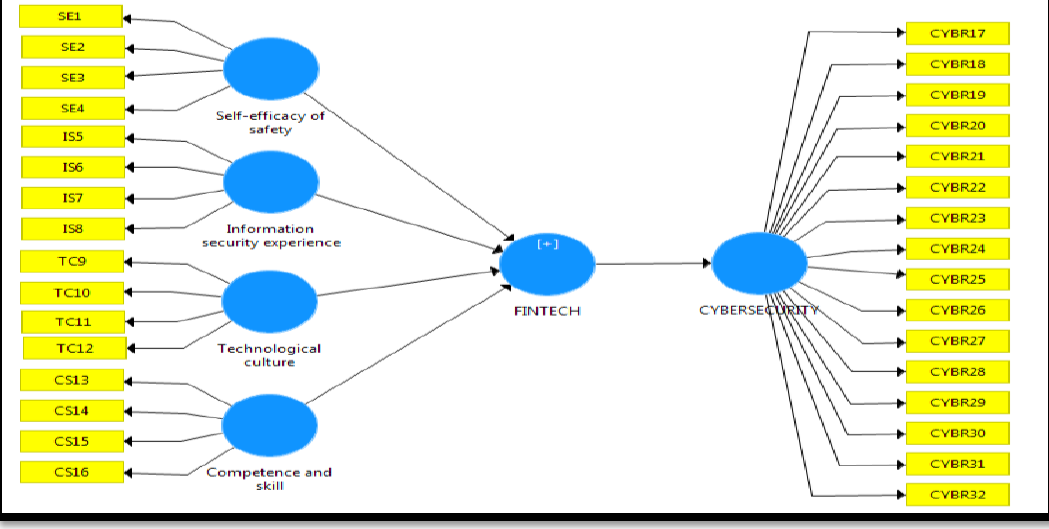
Figure 1 : research proposed